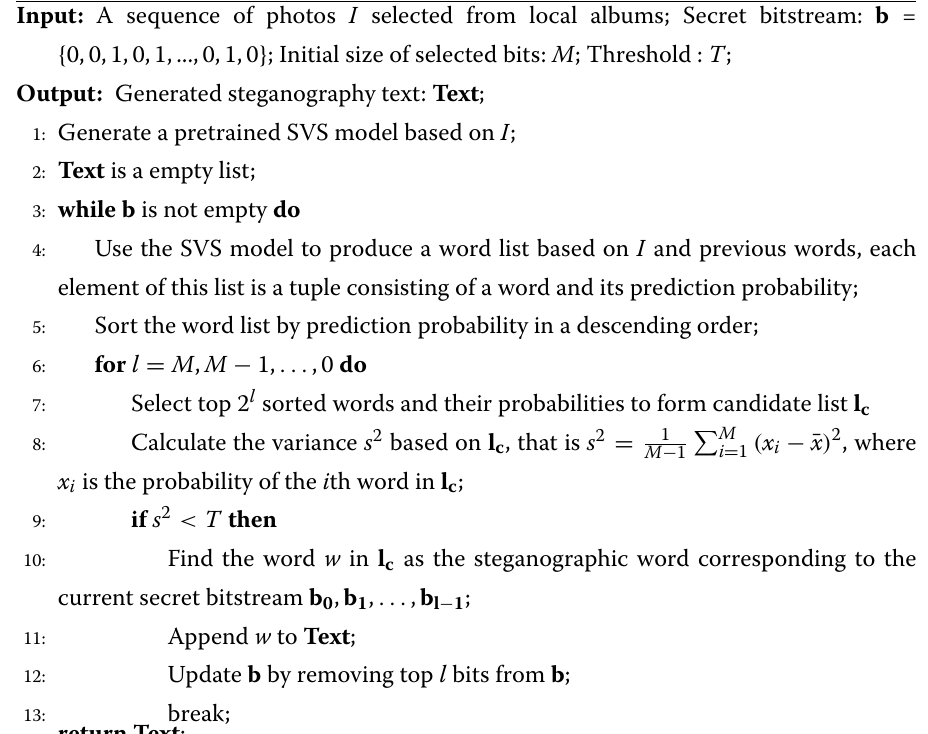
Algorithm 1 Adaptive Information Hiding